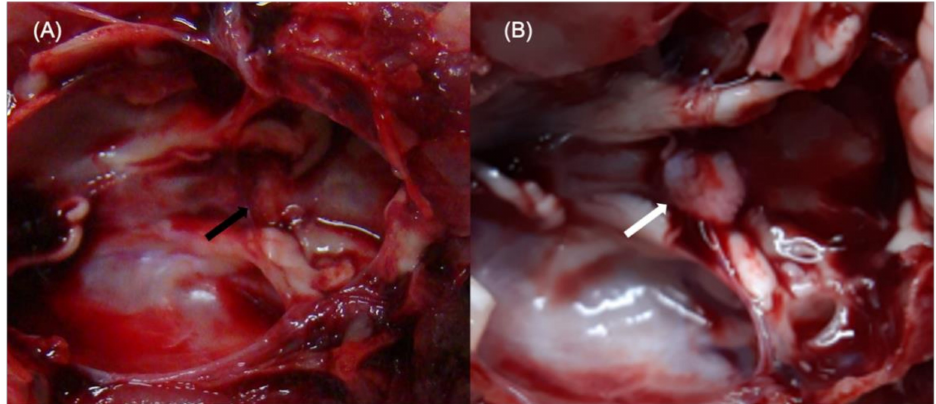
Figure 3. ( A ) Adequate removal of pituitary gland. A small remnant of the pituitary gland (black arrow) was shown in the sellar fossa on microscopic examination. ( B ) In contrast, large amounts of remnant pituitary gland (white arrow) were shown in cases with inadequate removal of the pituitary